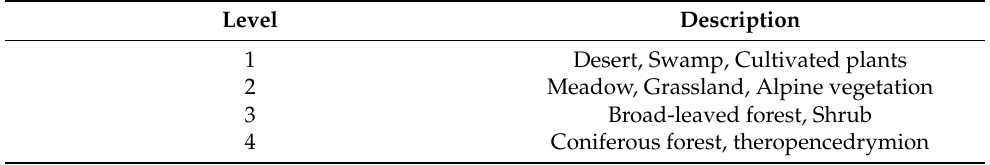
Table 1. Classification of Vegetation Types.